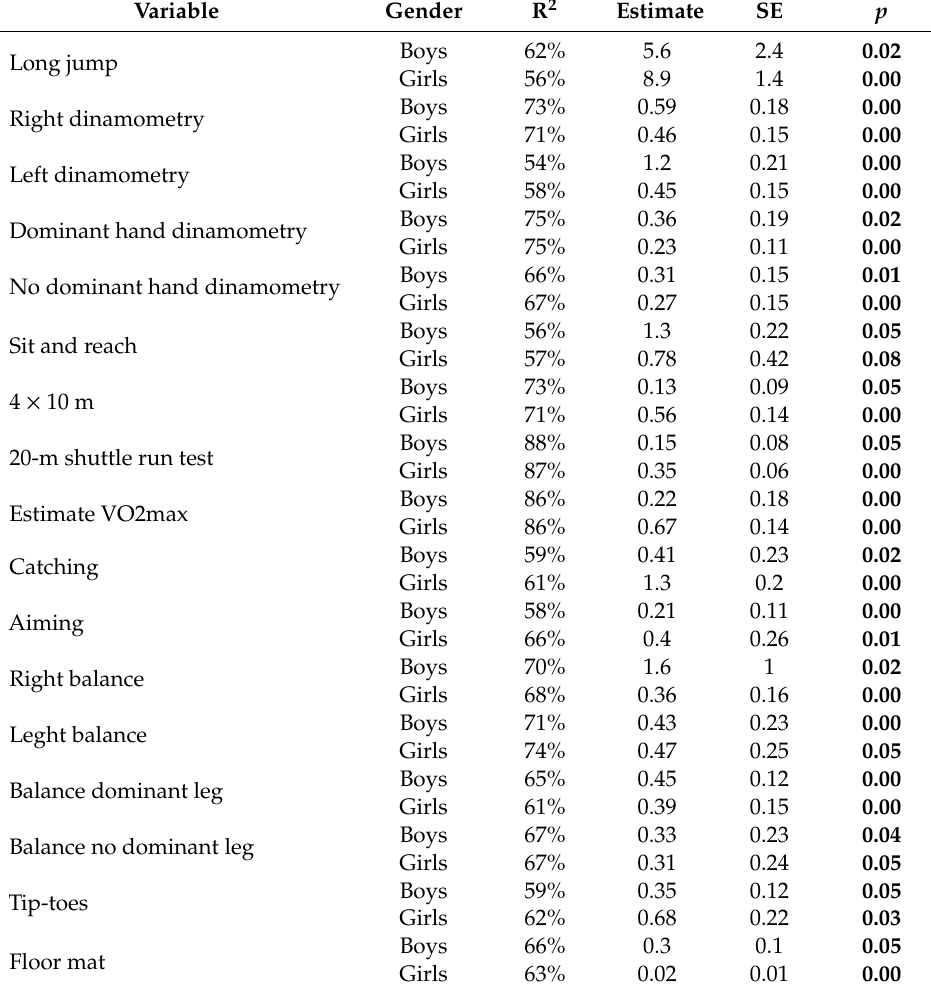
Table 4. Linear regression model for fitness level and gross motor skills outcomes adjusted by gender, age in months, height, weight, and